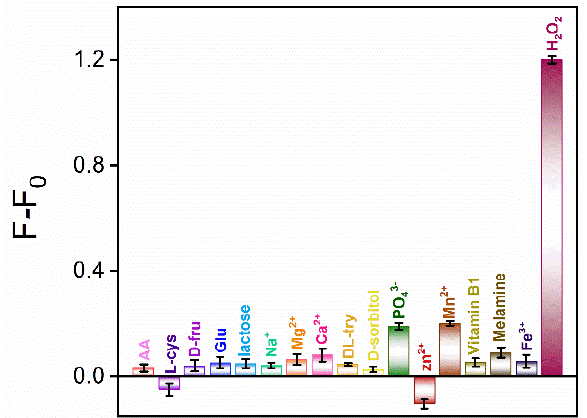
Figure 8. The change in fluorescence intensity ratioof OPD + CDs solution in the absence (F 0 ) or presence (F) of different substances. F and F 0 were calculated using the fluorescence intensity ( I ) at 560 nm and 450 nm (F = I 560 / I 450 ) in each reaction system, respectively. The concentrations of H 2 O 2 , Fe 3+ , and other substances were 0.2 mM, 0.6 μ g/mL, and 4 mM, respectively. The H 2 O 2 in milk was detected with a standard addition method. As shown in Table 2, a good recovery, ranging from 97.0% to 102%, was obtained when the constructed ratiometric fluorescence sensor was applied to detect H 2 O 2 . The relative standard deviation (RSD) of the determination was less than 2.9%, proving good reliability.